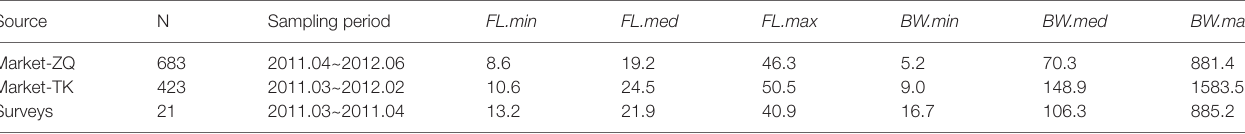
TABLE 2 | Information on brushtooth lizardfish samples collected by different sources.